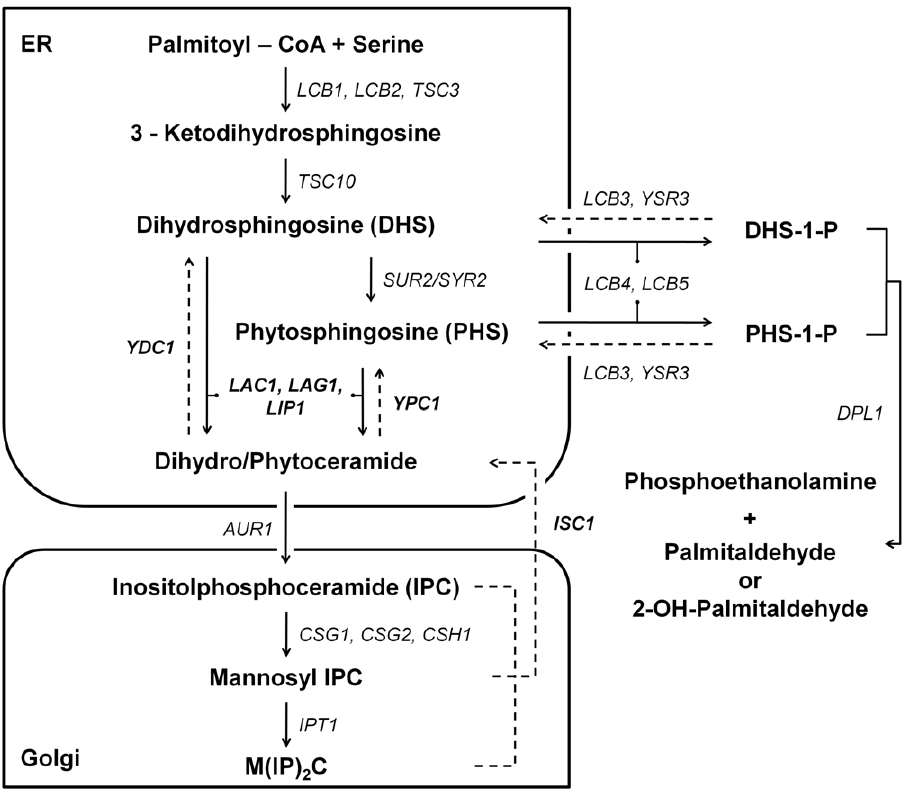
Figure 1. Sphingolipids metabolism in yeast. Schematic overview of yeast sphingolipid metabolism displaying the metabolic intermediates, genes involved and cellular locations of the enzymatic reactions.